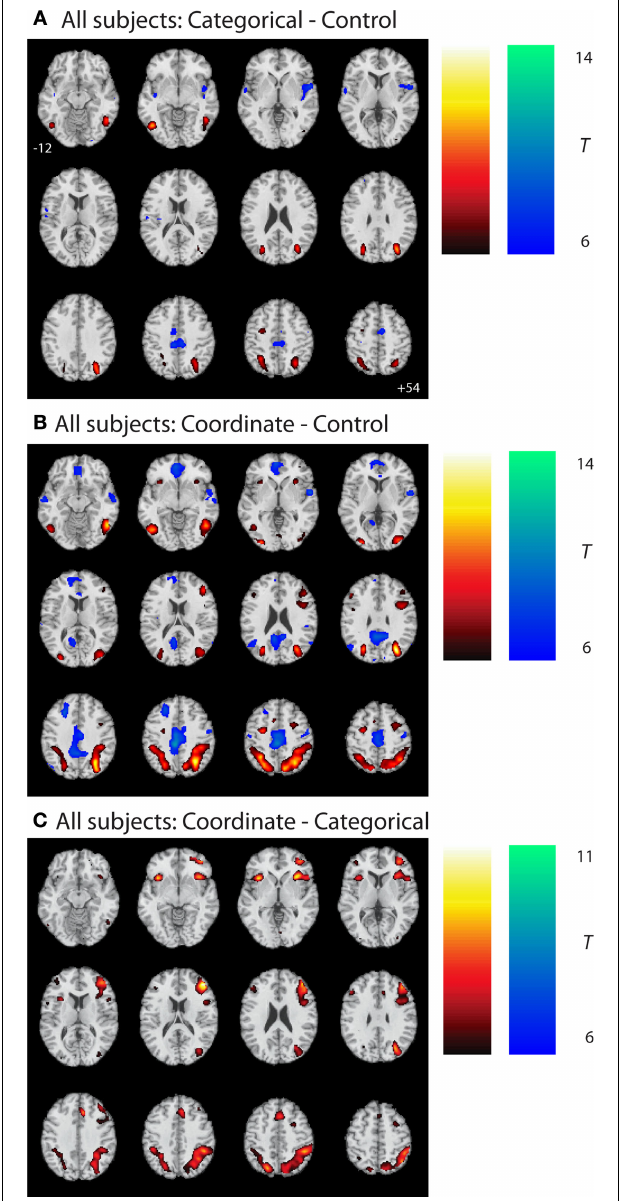
FIGURE 2 | Group statistical maps, all subjects. (A) Categorical–control task T- map for young and old grouped together. (B) Coordinate–control task T- map for young and old together. (C) Coordinate–categorical tasks T- map for young and old combined. Note that the reverse contrast reveals no signifi cant activation. All maps thresholded with FWE correction at p < 0.05, and reverse contrasts shown in cold